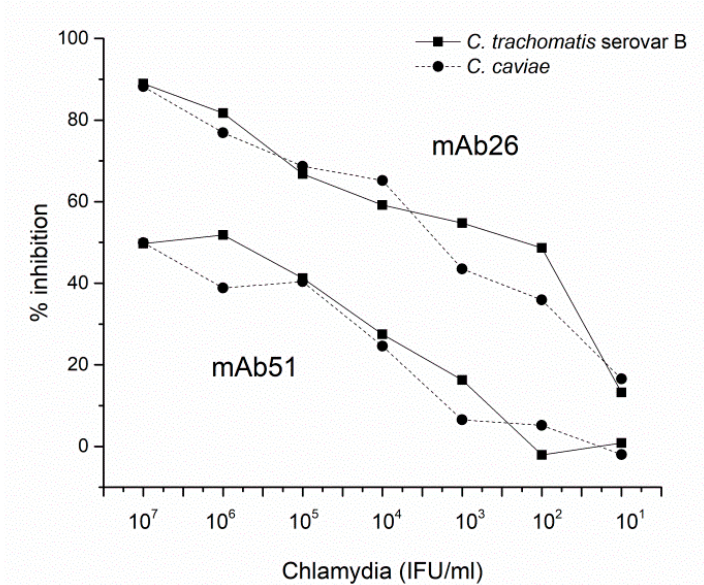
Figure 3. The capacity of chlamydial elementary bodies (EBs; C. trachomatis serovar B and C. caviae ) to inhibit the binding of mAb26 and mAb51 to TTd. The results represent the percentage inhibition of mAb26 and mAb51 binding to TTd with chlamydial EBs: C. trachomatis serovar B and C. caviae (both: 1 × 10 7 –1 × 10 1 IFU/mL). The percentage (%) of inhibition was calculated from recorded optical density (OD) values, taking the one recorded in wells with mAbs alone as a 100% binding.